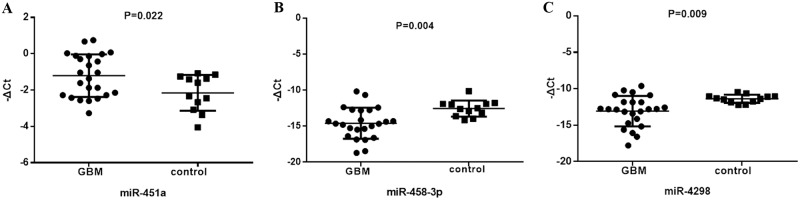
Validation of serum levels of miR-451a, miR-485-3p and miR-4298 by qRT-PCR in GBM patients.The average serum levels of the 3 miRNAs in GBM patients (n = 24) were compared with those in healthy volunteer controls (n = 12). (A) serum level of miR-451a in GBM patients is significantly higher than that in healthy controls. (B) serum level of miR-485-3p in GBM patients is significantly lower than that in healthy controls. (C) serum level of miR-4298 in GBM patients is significantly lower than that in healthy controls. The serum levels of the 3 miRNAs in GBM patients are in concordance with the results of microarray analysis. miRNA levels in each sample were normalized to miR-16. ΔCt = mean value of Ct (reference miRNA16)–mean value of Ct (target miRNA).